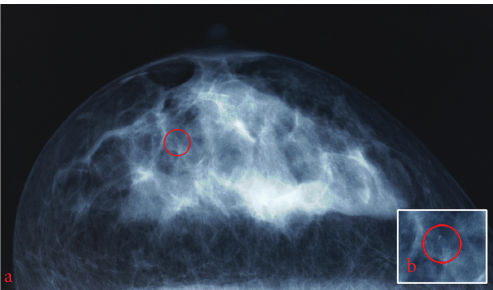
Figure 1: Radiologic aspects presenting small microcalcifications (a,